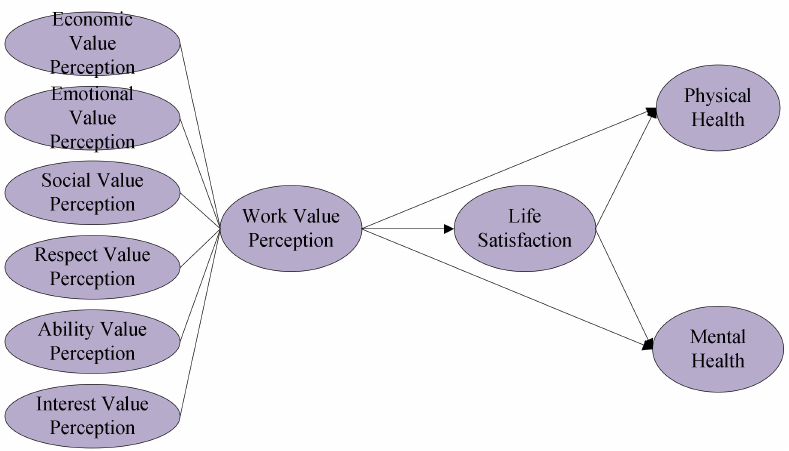
Figure 1. Research